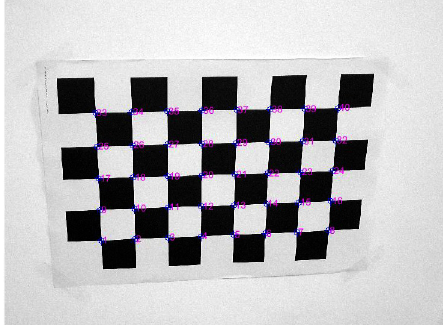
Figure 3. The 40 extracted points in some photo (captured by telephoto lens)